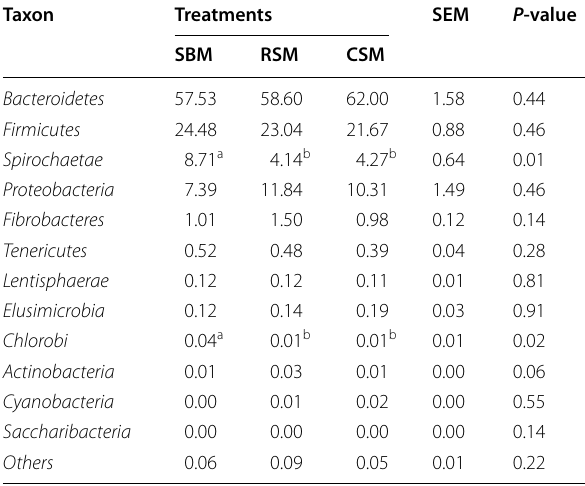
Table 5 Effects of different dietary protein source on the relative abundance (%) of the ruminal bacterial at phylum